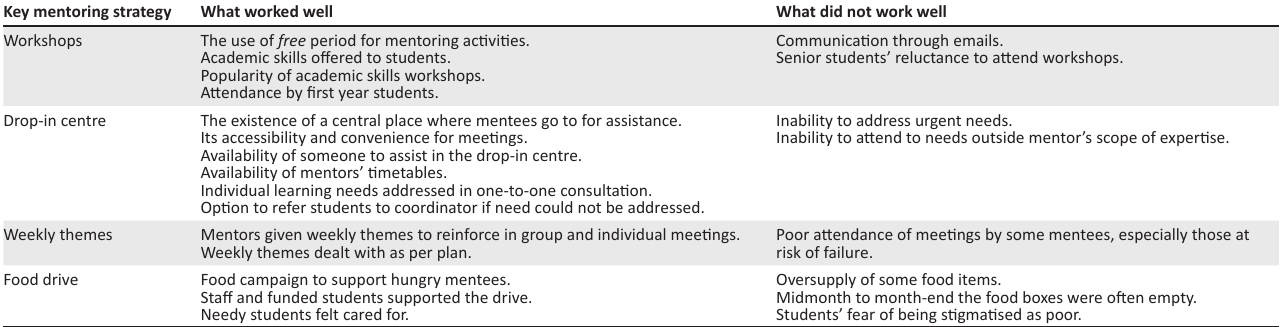
TABLE 1: Participants’ views on key structured intervention